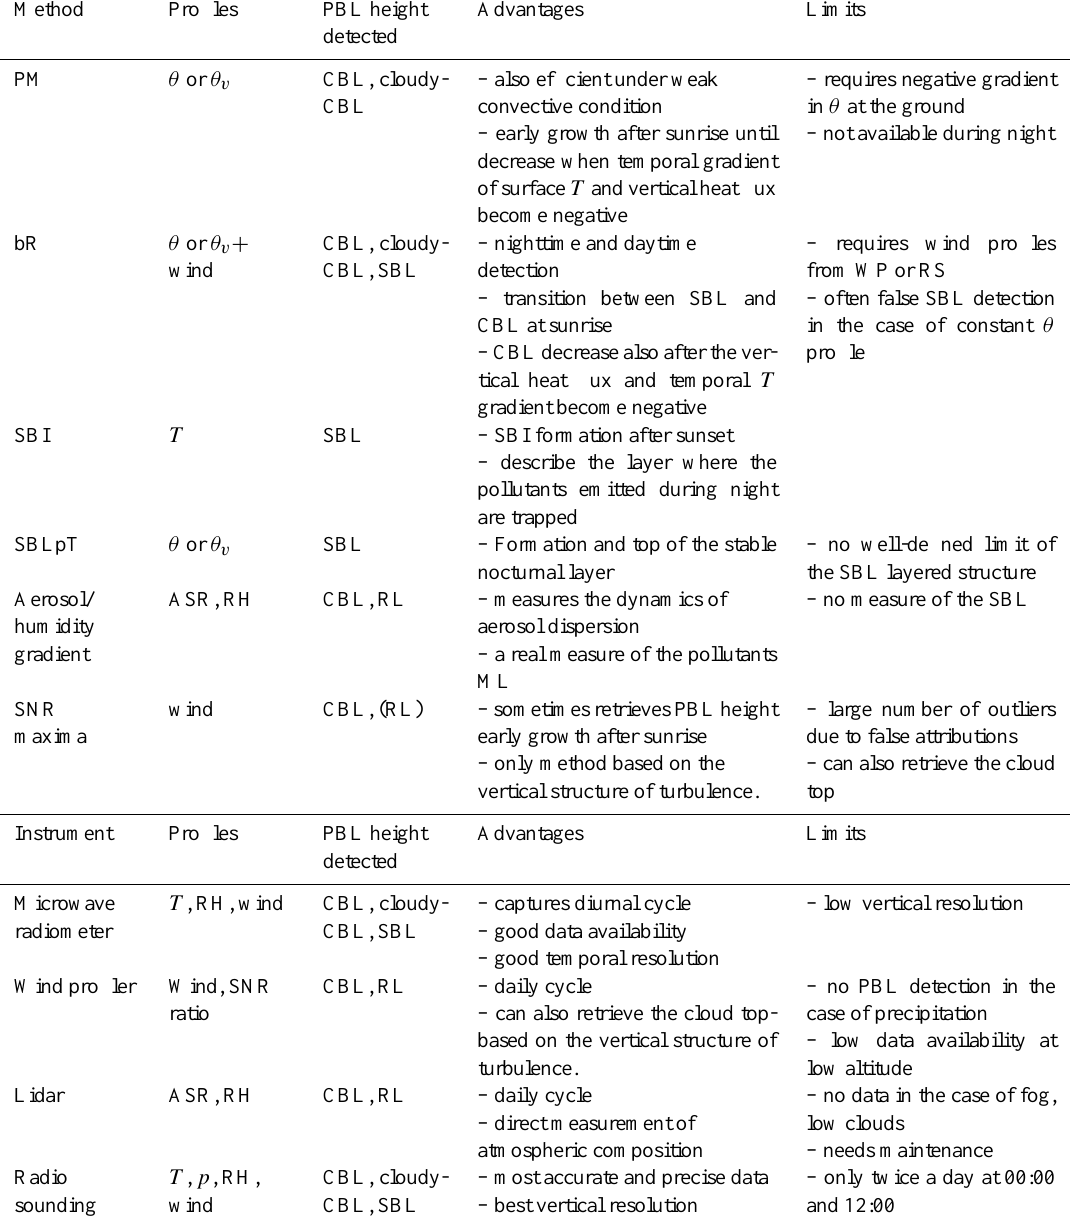
Table 4. Advantages and limits of detection methods and instruments to estimate the PBL